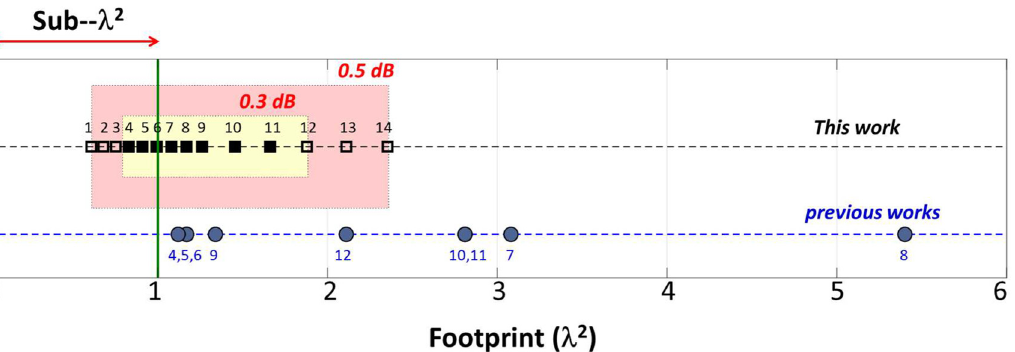
Figure 9: Spectrum of devices that simultaneously exhibit small footprints and low losses (orange region below 0.5 dB, yellow region: below 0.3 dB). The numbers on black dotted line represent the device numbers on Table 4. The numbers on the blue line are the reference numbers.